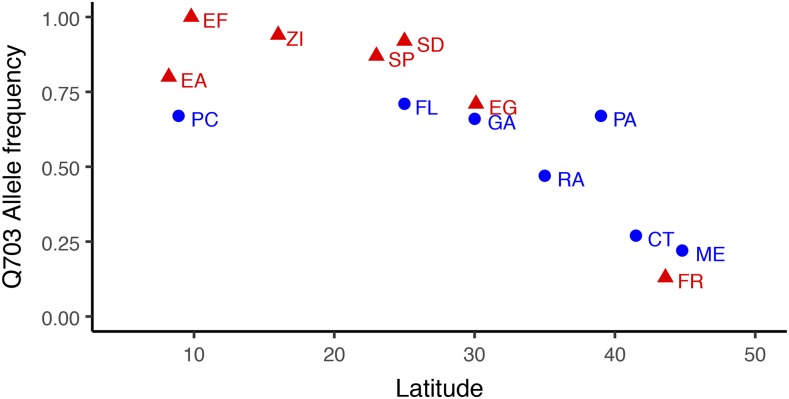
Frequencies of the Mnn1 Q allele in Old World and New World samples: In blue is the New World cline: Panama (PC), Florida (FL), Georgia (GA), N. Carolina (RAL), Pennsylvania (PA), Connecticut (CT), Maine (ME). In red is the Old World cline: Ethiopia low altitude (EA), Ethiopia high altitude: 3070m (EF), Zimbabwe (ZI), South Africa low altitude (SP), South Africa high altitude: 2000m (SD), Egypt (EG), France (FR)